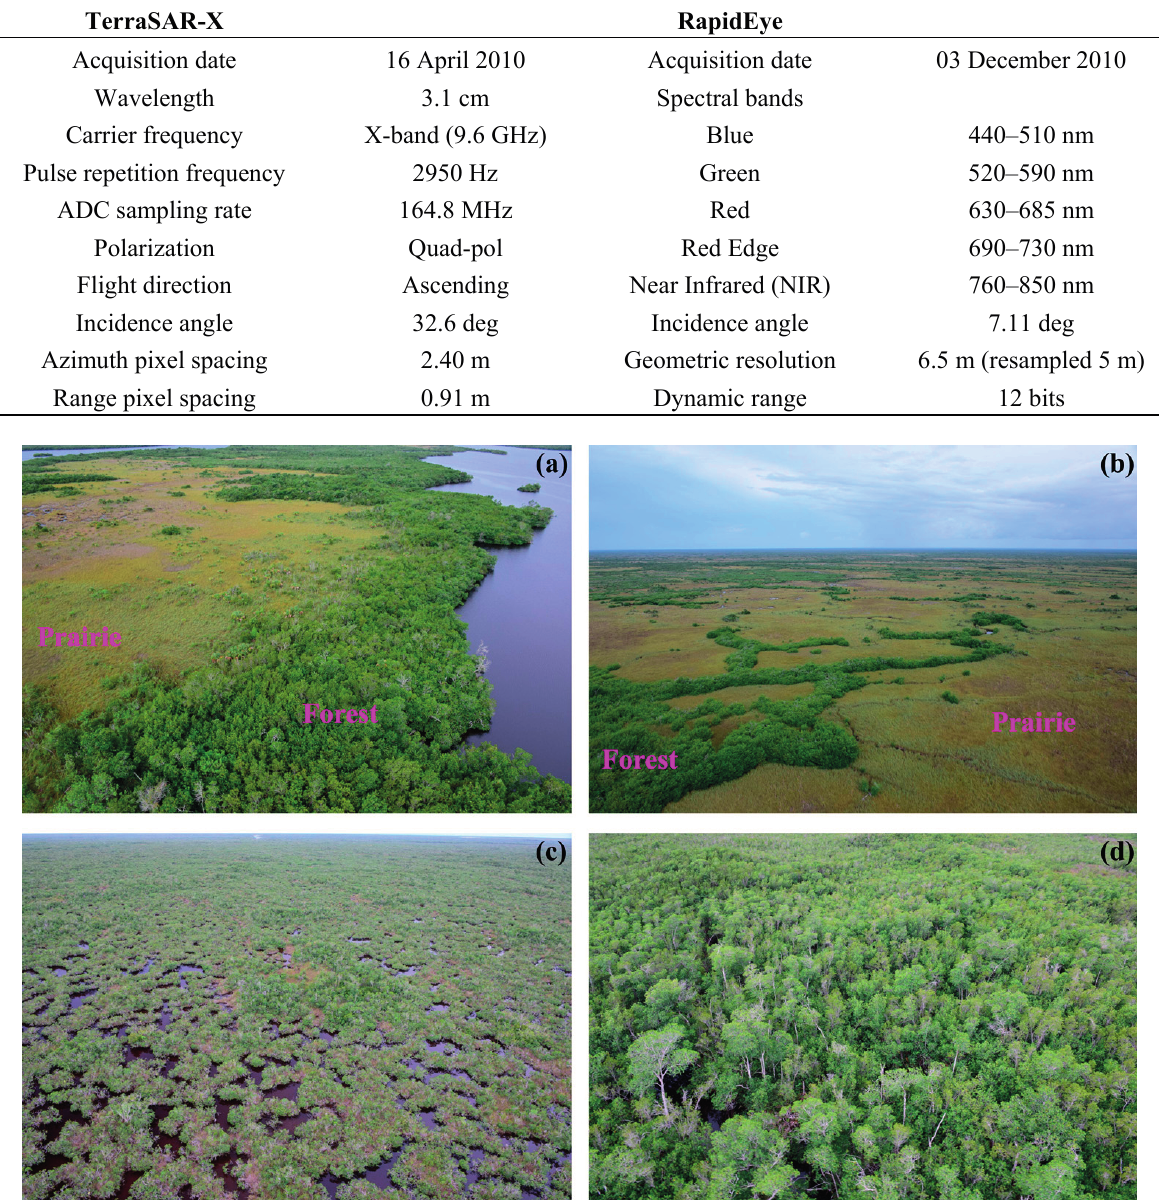
Table 1. Characteristics of the TerraSAR-X (TSX) and RapidEye data used in this study.